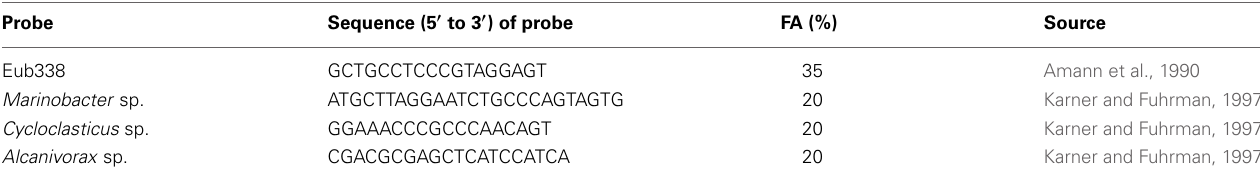
Table 1 | CARD-FISH specific probes used in the present